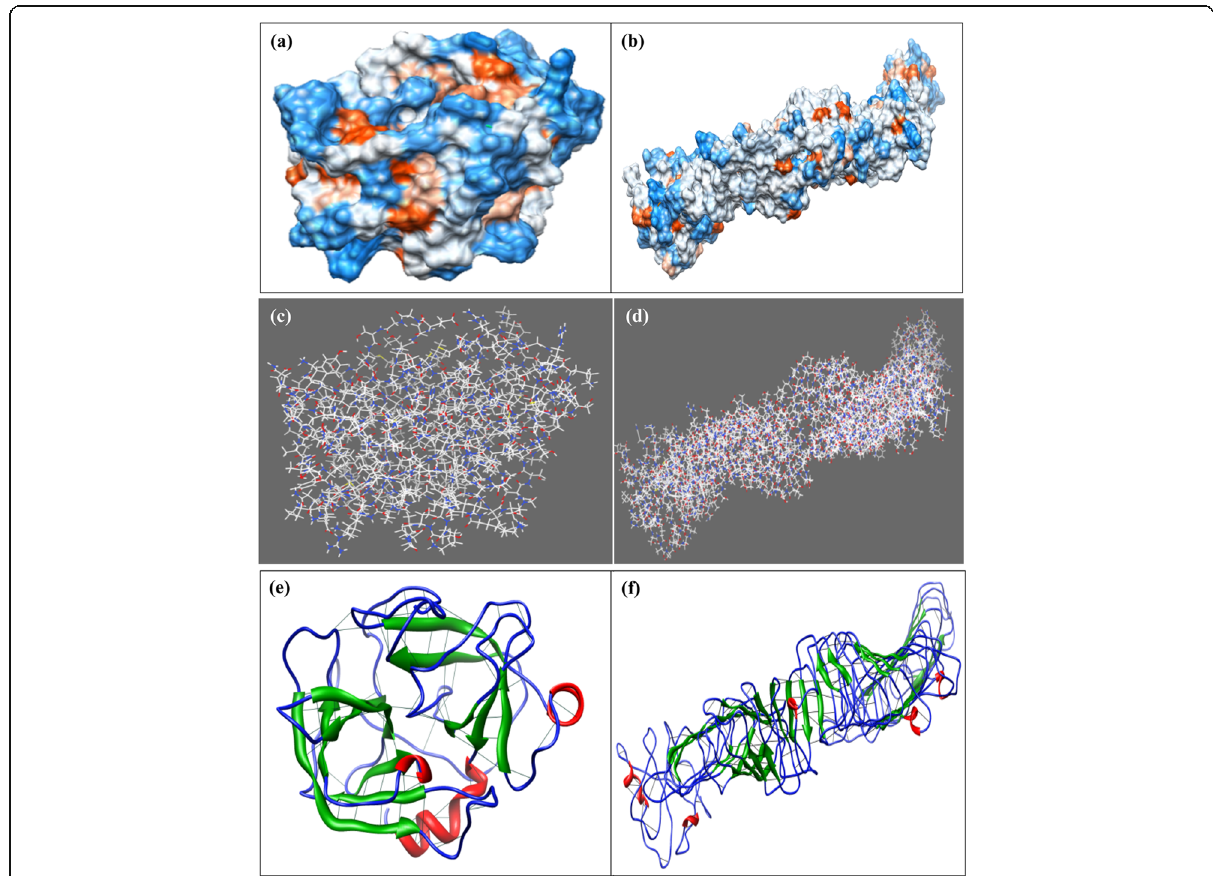
Fig. 11 Cocoonase ( a ) and sericin ( b ) showing UCSF Chimera predicted the hydrophobicity of the protein. Blue color is showing the hydrophilic part of the protein, and orange color is showing the hydrophobic part of the protein. Cocoonase ( c ) and sericin ( d ) showing UCSF Chimera predicted every single atoms of the protein. Cocoonase ( e ) and sericin ( f ) showing UCSF Chimera predicted hydrogen bond in the protein models predicted by